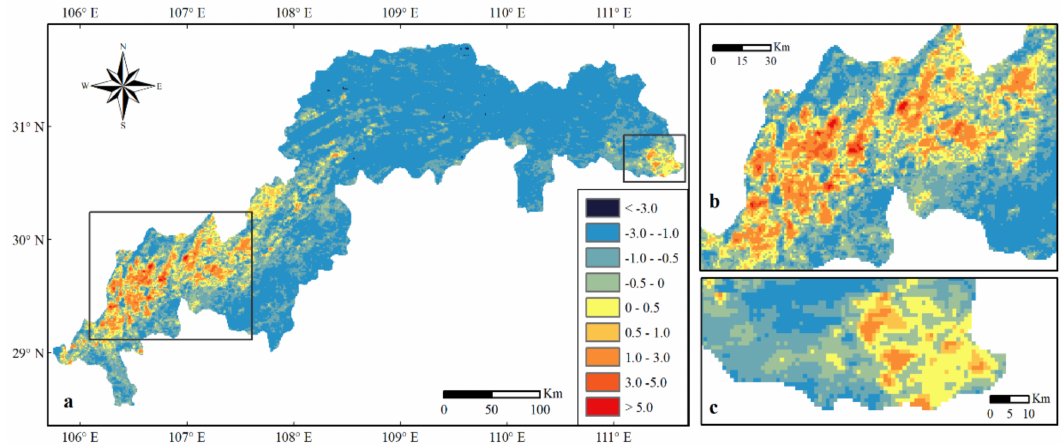
Figure 7. Change of land surface temperature (LST) ( ◦ C) in the TGRC in the period of